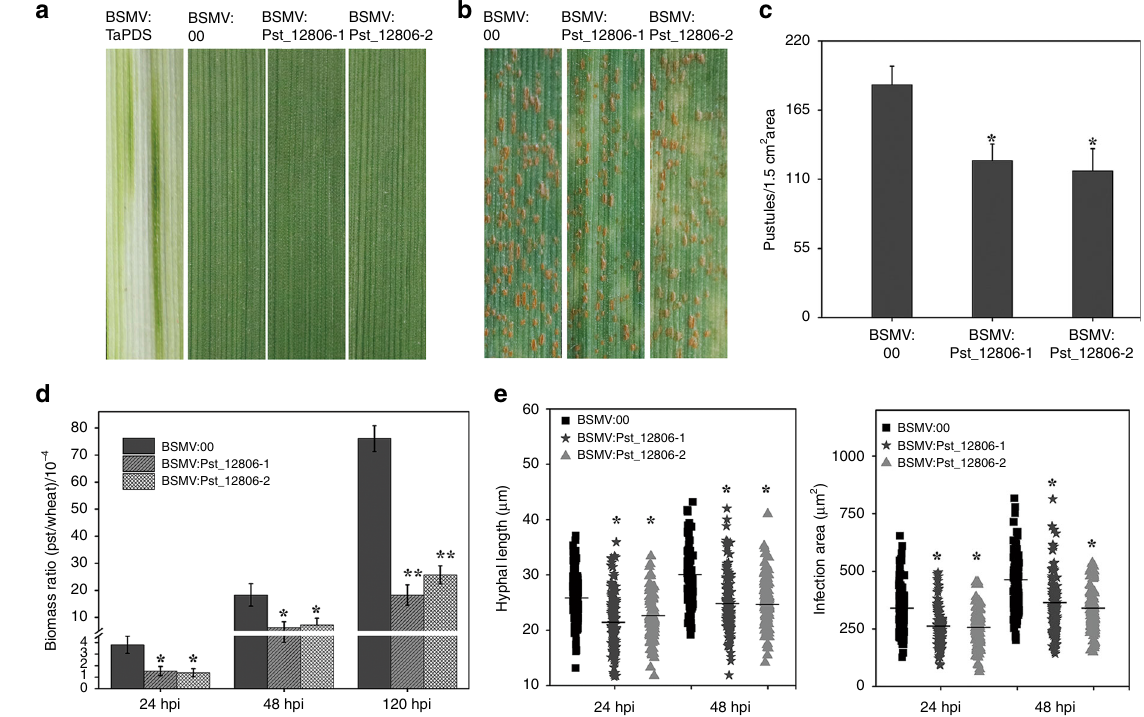
Fig. 4 Silencing Pst_12806 weakens the virulence of Pst . a The second leaves of two-leaf stage wheat cultivar Suwon 11 were inoculated with barley stripe mosaic virus BSMV: 00 and recombinant BSMV: TaPDS , BSMV: Pst_12806-1 , BSMV: Pst_12806-2 , and the virus phenotypes were observed and photographed at 10 days after inoculation. b Seedlings of cultivar Suwon 11were inoculated with the labeled BSMV constructs on the second leaf for 10 days and then inoculated with urediniospores of Pst CYR31 on the fourth leaf. Leaves infected with Pst were examined at 14 dpi. c The number of uredinium pustules formed by Pst per 1.5 cm 2 on the fourth leaves of wheat plants treated with the labeled BSMV were scored at 14 dpi. Mean and standard deviation were calculated with results from three independent replicates, with 15 – 20 leaves examines in each replicate. The asterisks indicate signi fi cant difference ( P < 0.05). d The Pst /wheat biomass ratio was assayed by qRT-PCR with RNA isolated from the fourth leaves of the same set of wheat plants as Fig.4c at 24, 48, and 120 hpi as described 66 . TaEF-1 α and PstEF-1 α were used to normalize the RNA level of wheat leaves and Pst , respectively. Mean and standard deviations were calculated with data from three independent replicates. The asterisks indicate signi fi cant difference in samples with Pst_12806 silenced by HIGS in comparison with the control (* P < 0.05; ** P < 0.01). e The hyphal length and infection area of Pst on the fourth leaves of the same wheat samples of 4 days were analyzed with CellSens Entry software at 24 and 48 hpi. Means were calculated from 50 infection sites of three biological replicates and were represented as solid lines in the picture. An asterisk indicates signi fi cant differences ( P < 0.05) using unpaired two-tailed Student ’ s t